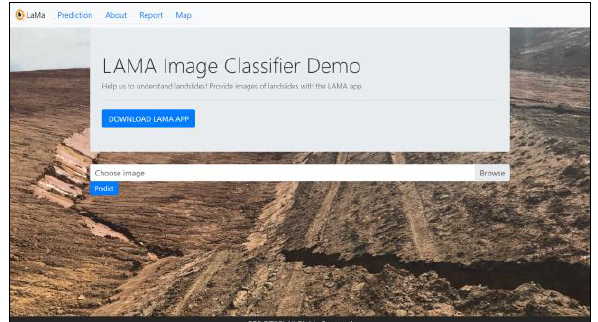
Figure 2. Homepage of the web interface in the presentation